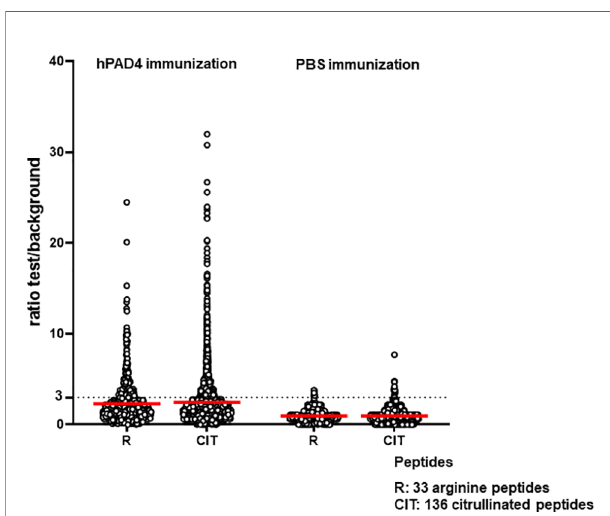
FIGURE 4 | Anti-arginine and citrullinated IgG responses in mice immunized with hPAD4 (n=20) or PBS (n=21). A ratio test/background was calculated for each arginine (R) and citrulinated peptide (CIT). A positive serum was de fi ned by a ratio higher than 3.